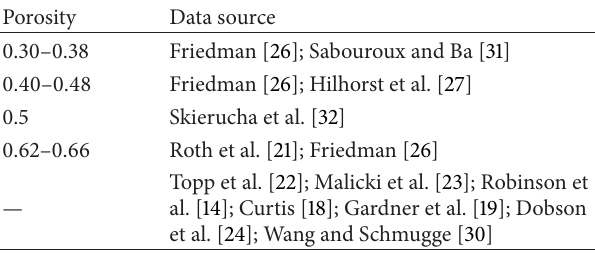
Table 2: Source of secondary data and porosity.